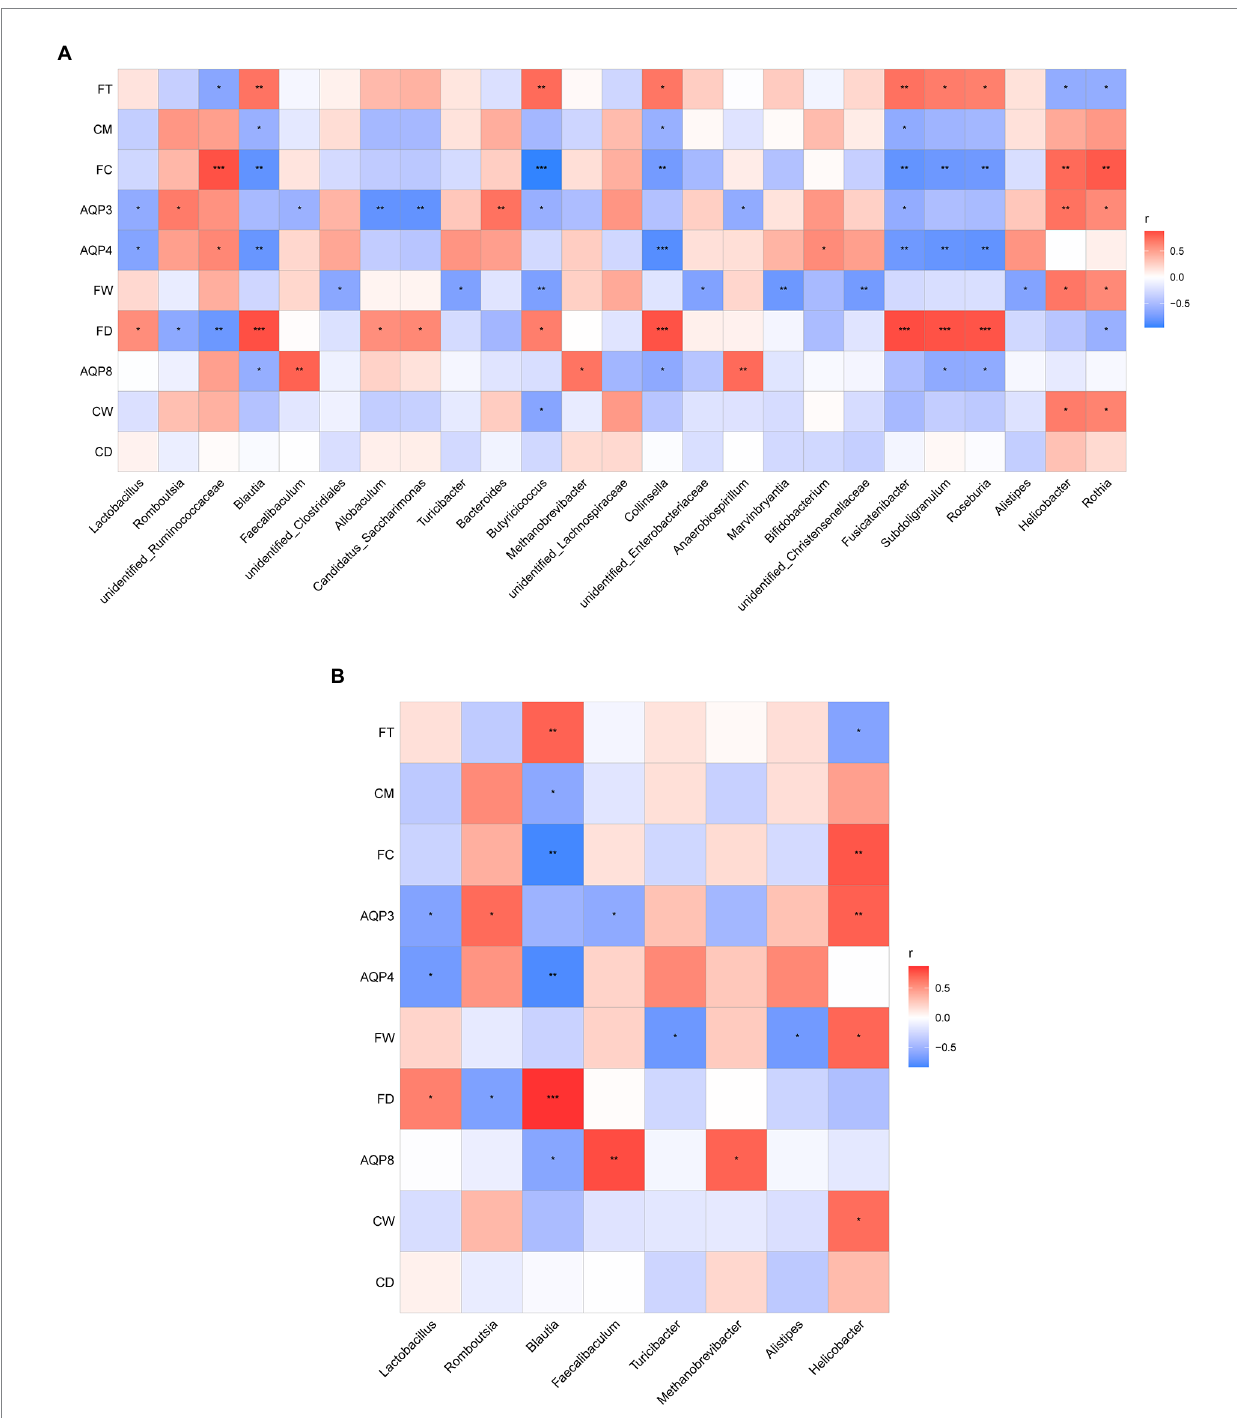
FIGURE 7 (A) Correlation analysis between the abundance of the top 25 microbes at the genus level and the related indexes of intestinal water metabolism. (B) Correlation analysis between the dominant microbes in different seasons and the related indexes of intestinal water metabolism. The ordinate is intestinal water metabolism and information on AQPs (CD, dry weight of colonic tissue; CW, wet weight of colonic tissue; CM, water content of colonic tissue; FD, fecal dry weight; FW, fecal wet weight; FC, fecal water content; FT, fecal excretion time). The abscissa is the genus level-related species information obtained through clustering. The Spearman correlation coefficient r( − 1 ≤ r ≤ 1) is expressed in a color shade. The darker red heatmap color indicates that r is closer to 1. When r < 0, the environmental factor is considered negatively correlated with the flora, and when r > 0, a positive correlation is considered, * p < 0.05, ** p < 0.01, *** p <